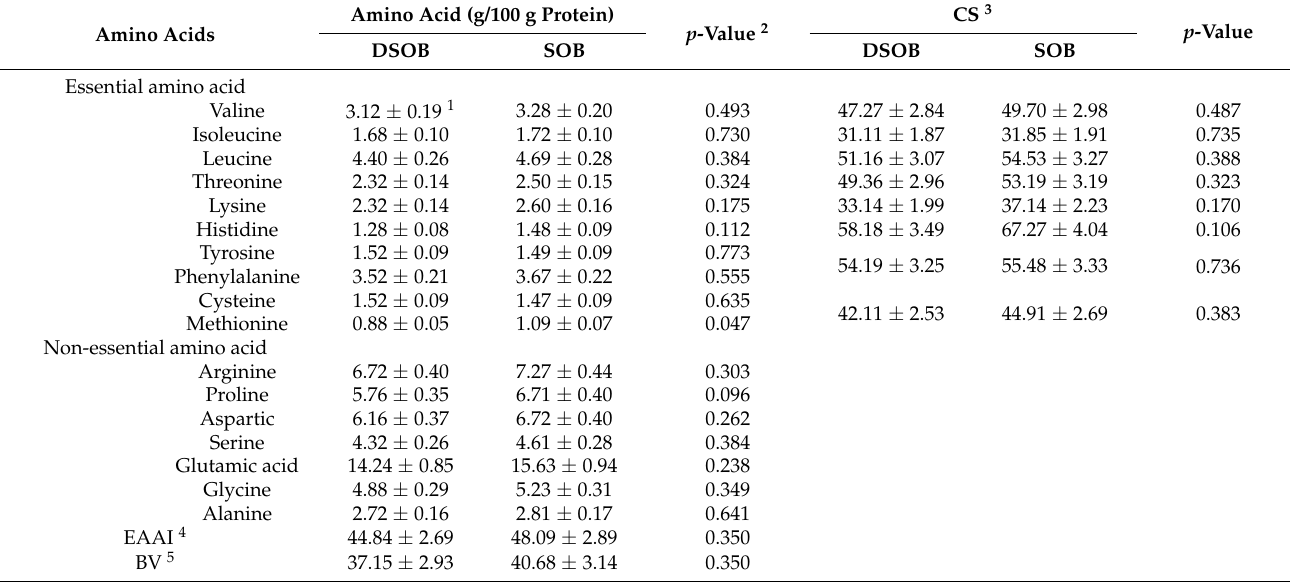
Table 7. Amino acid composition (%) of proteins in defatted seeds of Oenothera biennis (DSOB) and seeds of Oenothera biennis (SOB).